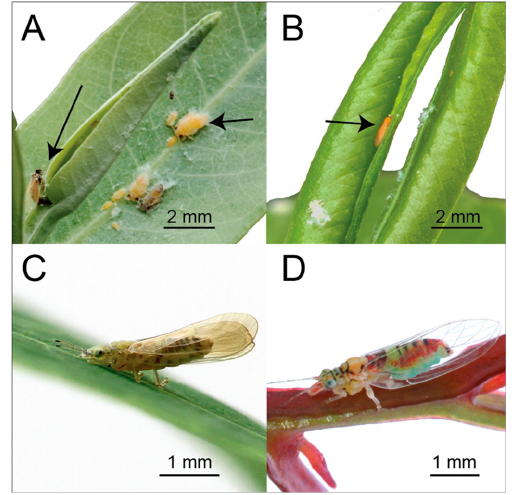
Figure 1. ( A ) Adult C. eucalypti (extreme left) ovipositing into the crevice of the apical bud of